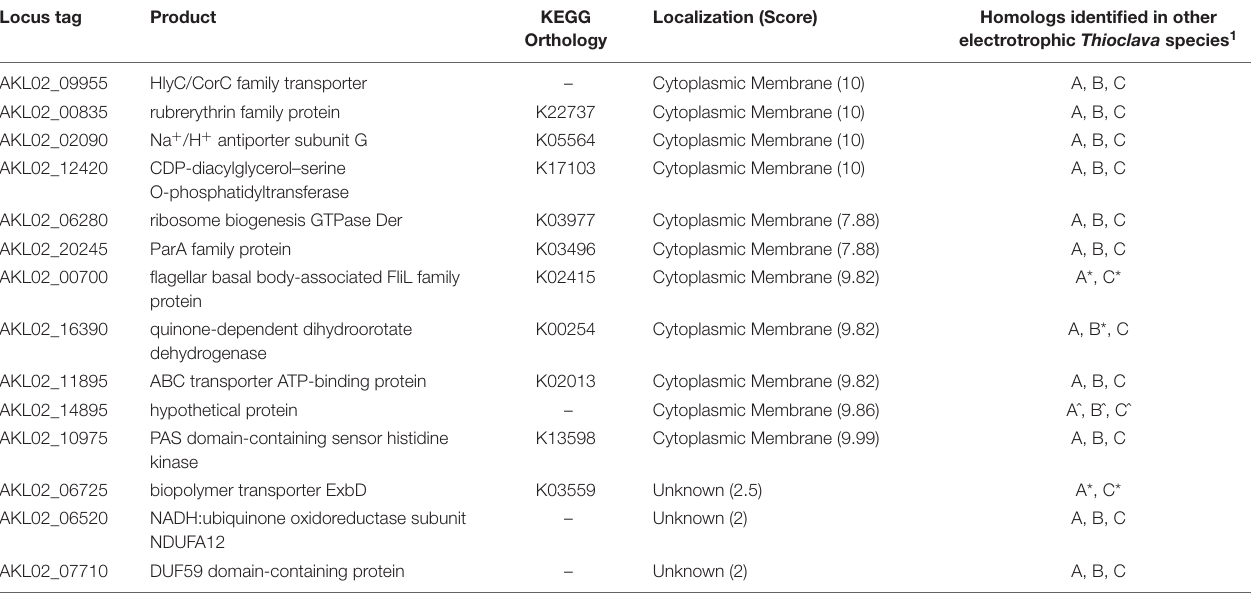
TABLE 3 | Essential genes in electrochemistry or electrochemistry/open circuit conditions predicted to localize to the cell membrane or of unknown localization. Locus